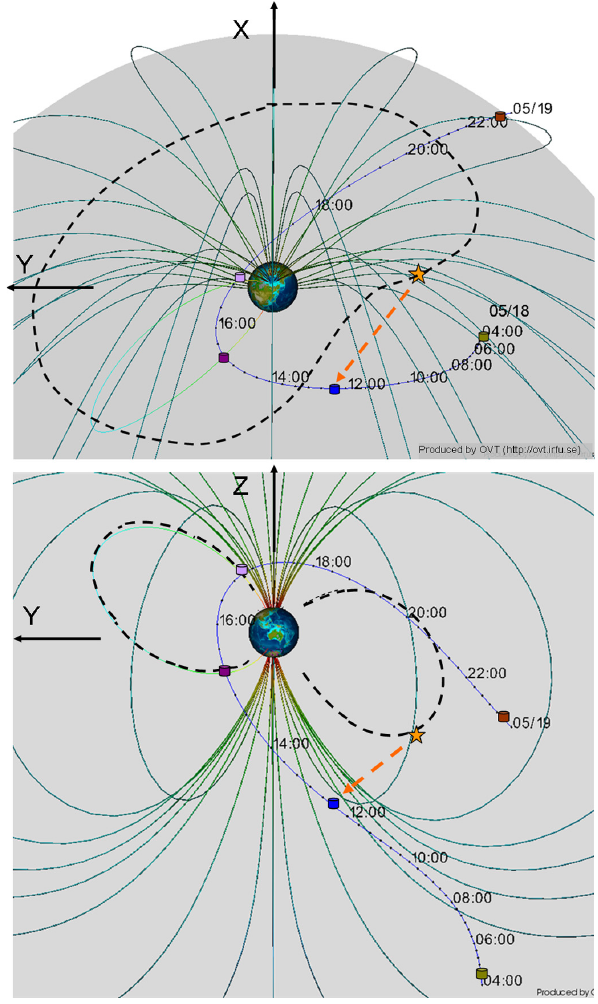
Fig. 11. Views in GSM coordinate system from OVT (Orbit Visu- alization Tool, http://ovt.irfu.se). C3–C4 orbit on 18 May 2008, and magnetopause field lines are projected unto X – Y plane (top) and Y – Z plane (bottom). The NTC source is indicated by a star; the ob- serving point at 12:20UTC by a blue symbol; other positions of the (C3–C4) pair by symbols in various colours. Plasmapause cross- ings, occurring at 15:20UTC and 16:50UTC in the dusk sector, are shown in dark and light purple. Magnetopause crossings, occurring at 04:20UTC and 23:30UTC, are shown in light green and brown. Dashed curves sketch possible positions of plasmapause, equato- rial boundary in upper panel, selected magnetic flux tubes along plasmapause surface in lower